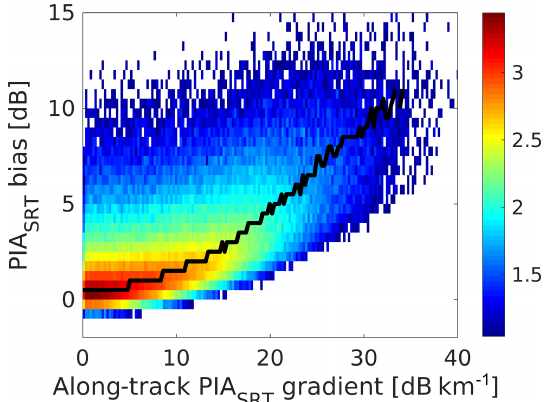
Figure 10. Density plot of PIA SRT bias (with respect to the true PIA) as a function of the absolute value of the along-track PIA SRT gradient for the entire dataset of simulations. A configuration for an EarthCARE-like configuration is considered (94GHz radar with a 0.5km IFOV). The black line corresponds to the modal values of the biases for a given absolute value of the PIA SRT along-track